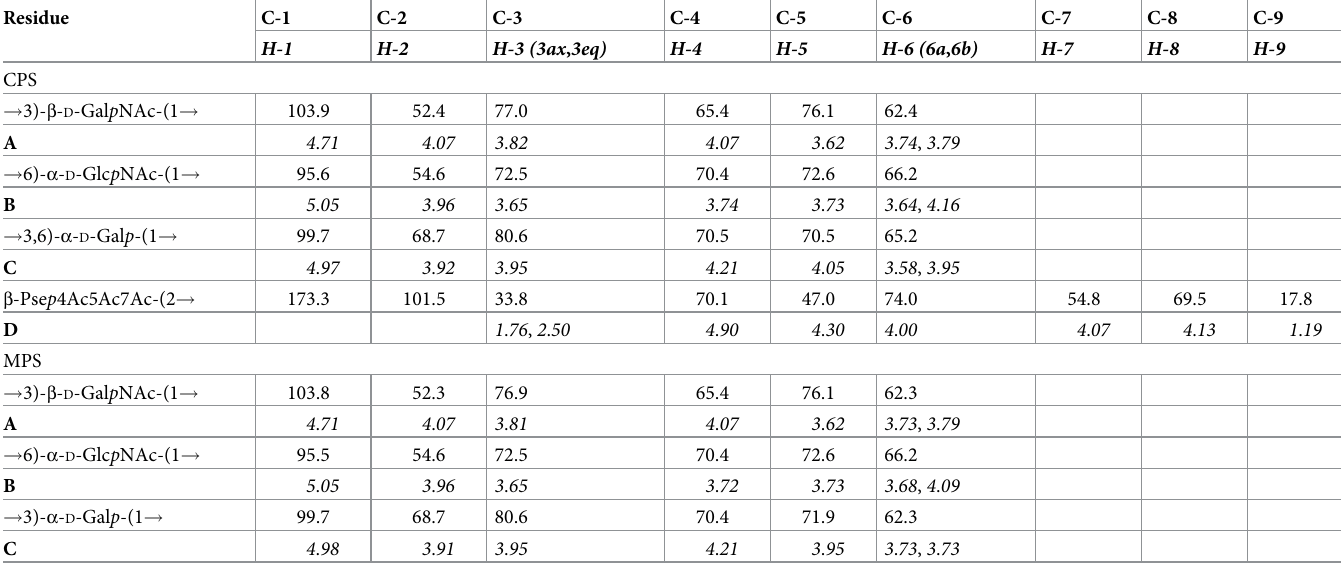
Table 1. 13 C and 1 H NMR chemical shifts of the capsular polysaccharide (CPS) and a modified polysaccharide (MPS) from A . baumannii NIPH 329 ( δ ,